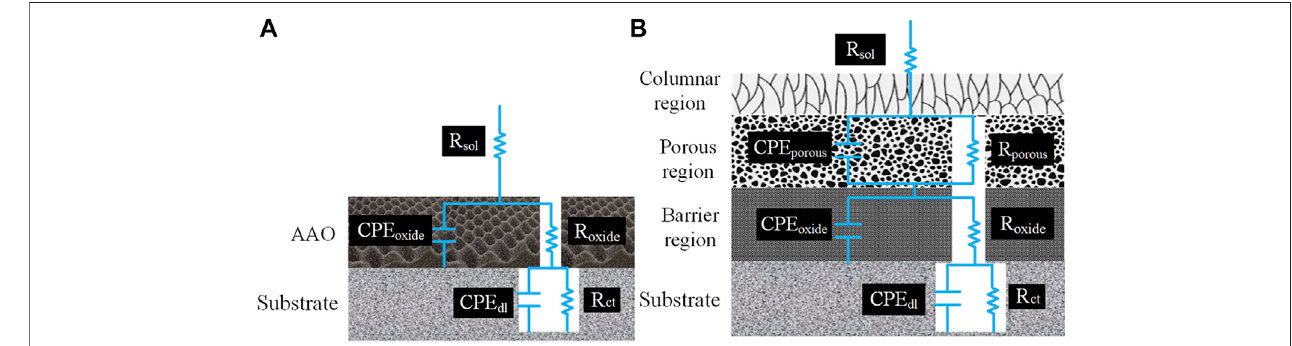
FIGURE 3 | Equivalent electric circuits used to fi t EIS spectra (A) without inhibitors and (B) with inhibitors.